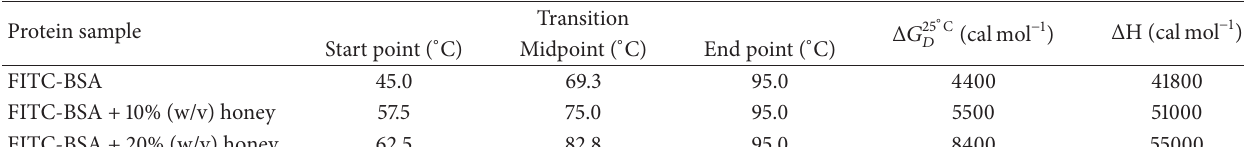
Table 2: Characteristics of thermal denaturation of FITC-BSA in the absence and presence of different honey concentrations as monitored by FITC fluorescence upon excitation at 495nm.